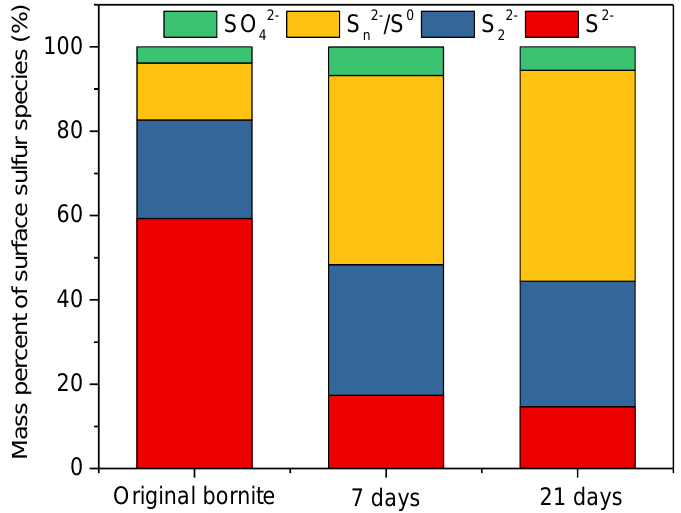
Figure 11. Compositions of sulfur species of bornite leached by L. ferriphilum at 7 days and 21 days.